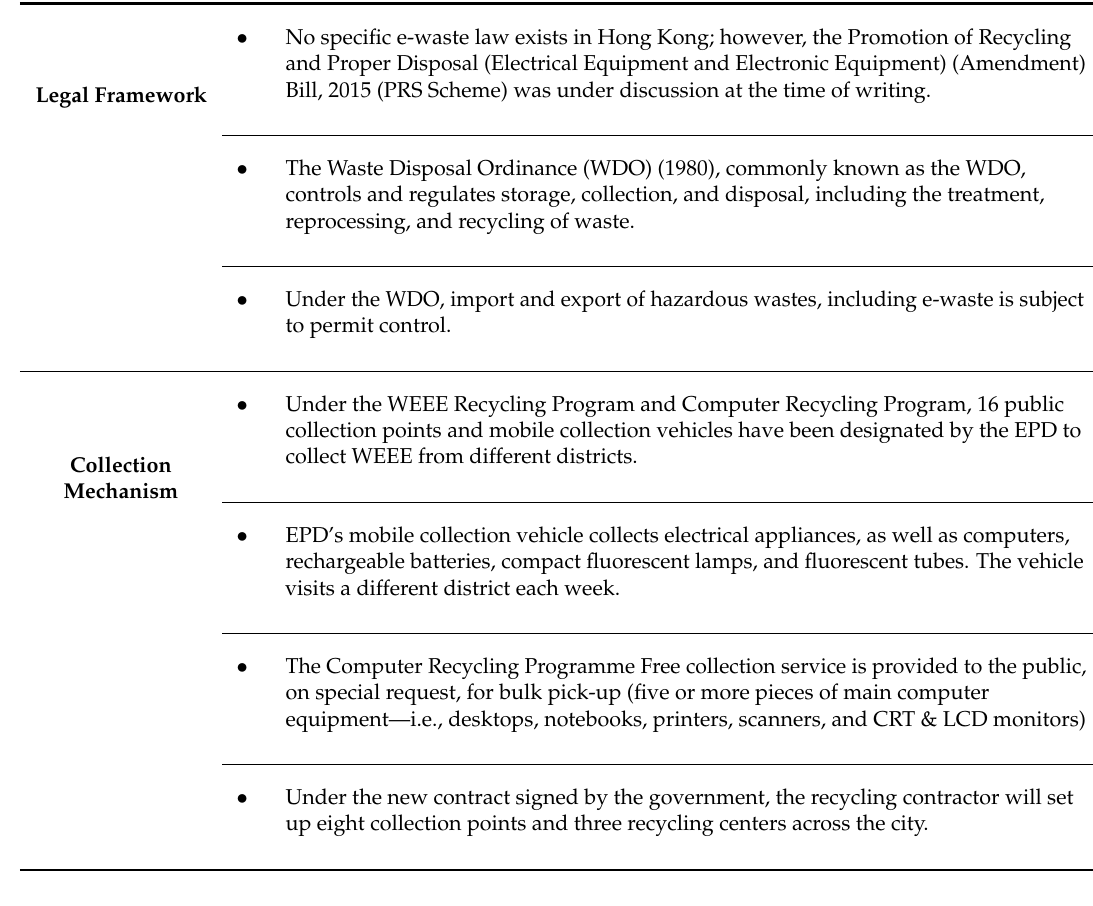
Table 2. Summary of WEEE management framework in Hong